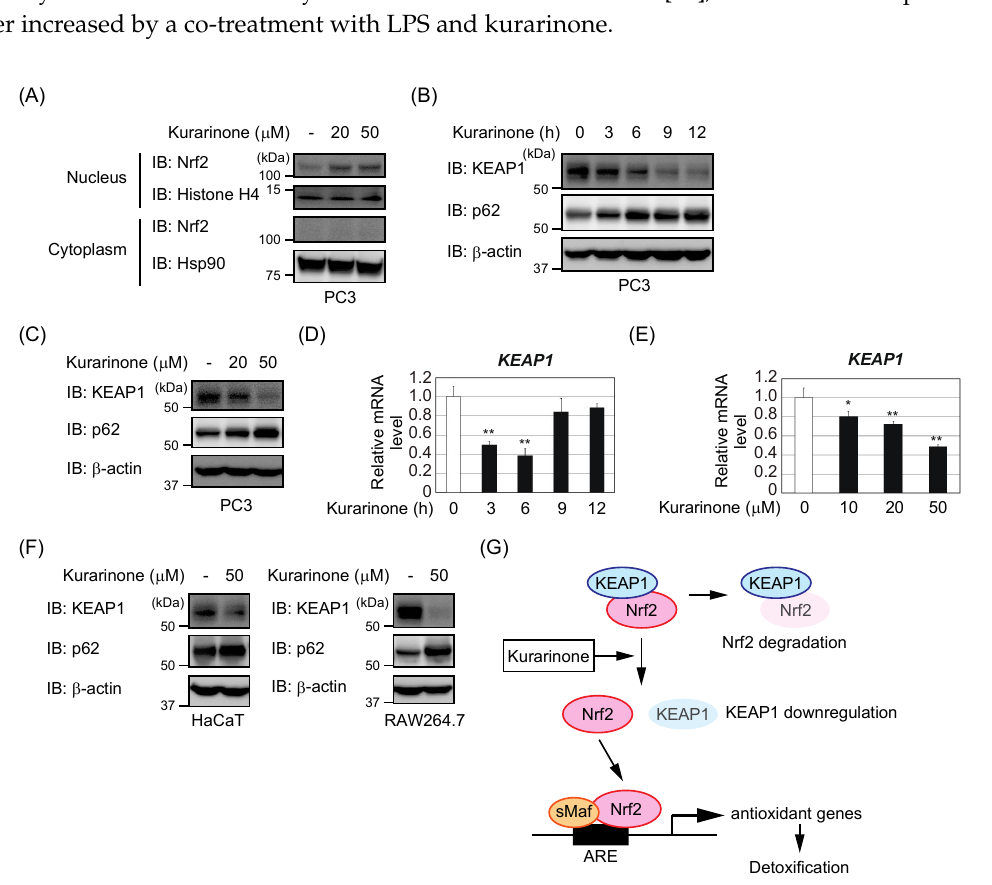
Figure 3. Kurarinone-induced KEAP1 downregulation contributes to the activation of Nrf2. ( A ) After treating the PC3 cells with the indicated doses of kurarinone for 6 h, nuclear and cytoplasmic extracts were subjected to immunoblotting with the indicated antibodies. ( B , D ) PC3 cells were treated with 50 μM kurarinone for the indicated periods. (B) Cell lysates were immunoblotted with the indicated antibodies. (D) The expression of KEAP1 mRNA was assessed by qPCR. The results were shown as the mean ± S.D. ( n = 3). ( C , E ) PC3 cells were treated with the indicated doses of kurarinone for 6 h. (C) Cell lysates were immunoblotted with the indicated antibodies, as in (B). (E) The expression of KEAP1 mRNA was assessed by qPCR, as in (D). Significant differences are indicated as ** p < 0.01, * p < 0.05 vs. the group without kurarinone-treatment. ( F ) HaCaT and RAW264.7 cells were treated with the indicated doses of kurarinone for 6 h. Cell lysates were immunoblotted with the indicated antibodies, as in (B). ( G ) Kurarinone downregulates KEAP1 expression, which might lead to the activation of Nrf2. In the nucleus, Nrf2 binds to small musculoaponeurotic fibrosarcoma (sMaf) as a partner, to activate the specific antioxidant responsive elements (ARE) present in gene promoters. It then elicits the transcription of several antioxidant genes, including heme-oxygenase 1 (HO-1), which induce